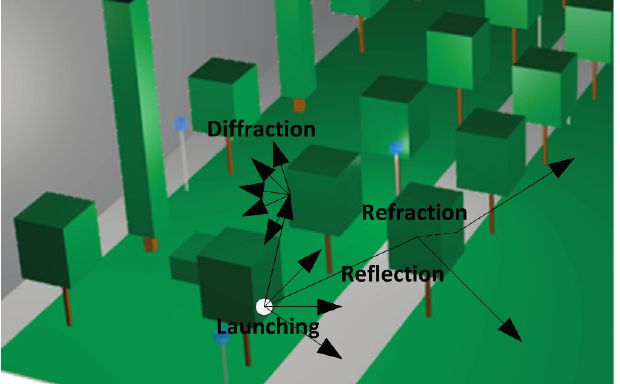
Figure 2. Schematic representation of the principle of operation of the in-house developed 3D Ray Launching algorithm.